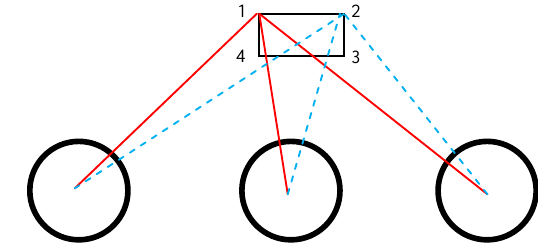
Figure 9. Multi-click approach. Finding the same corners of banners or billboards on three panoramas.